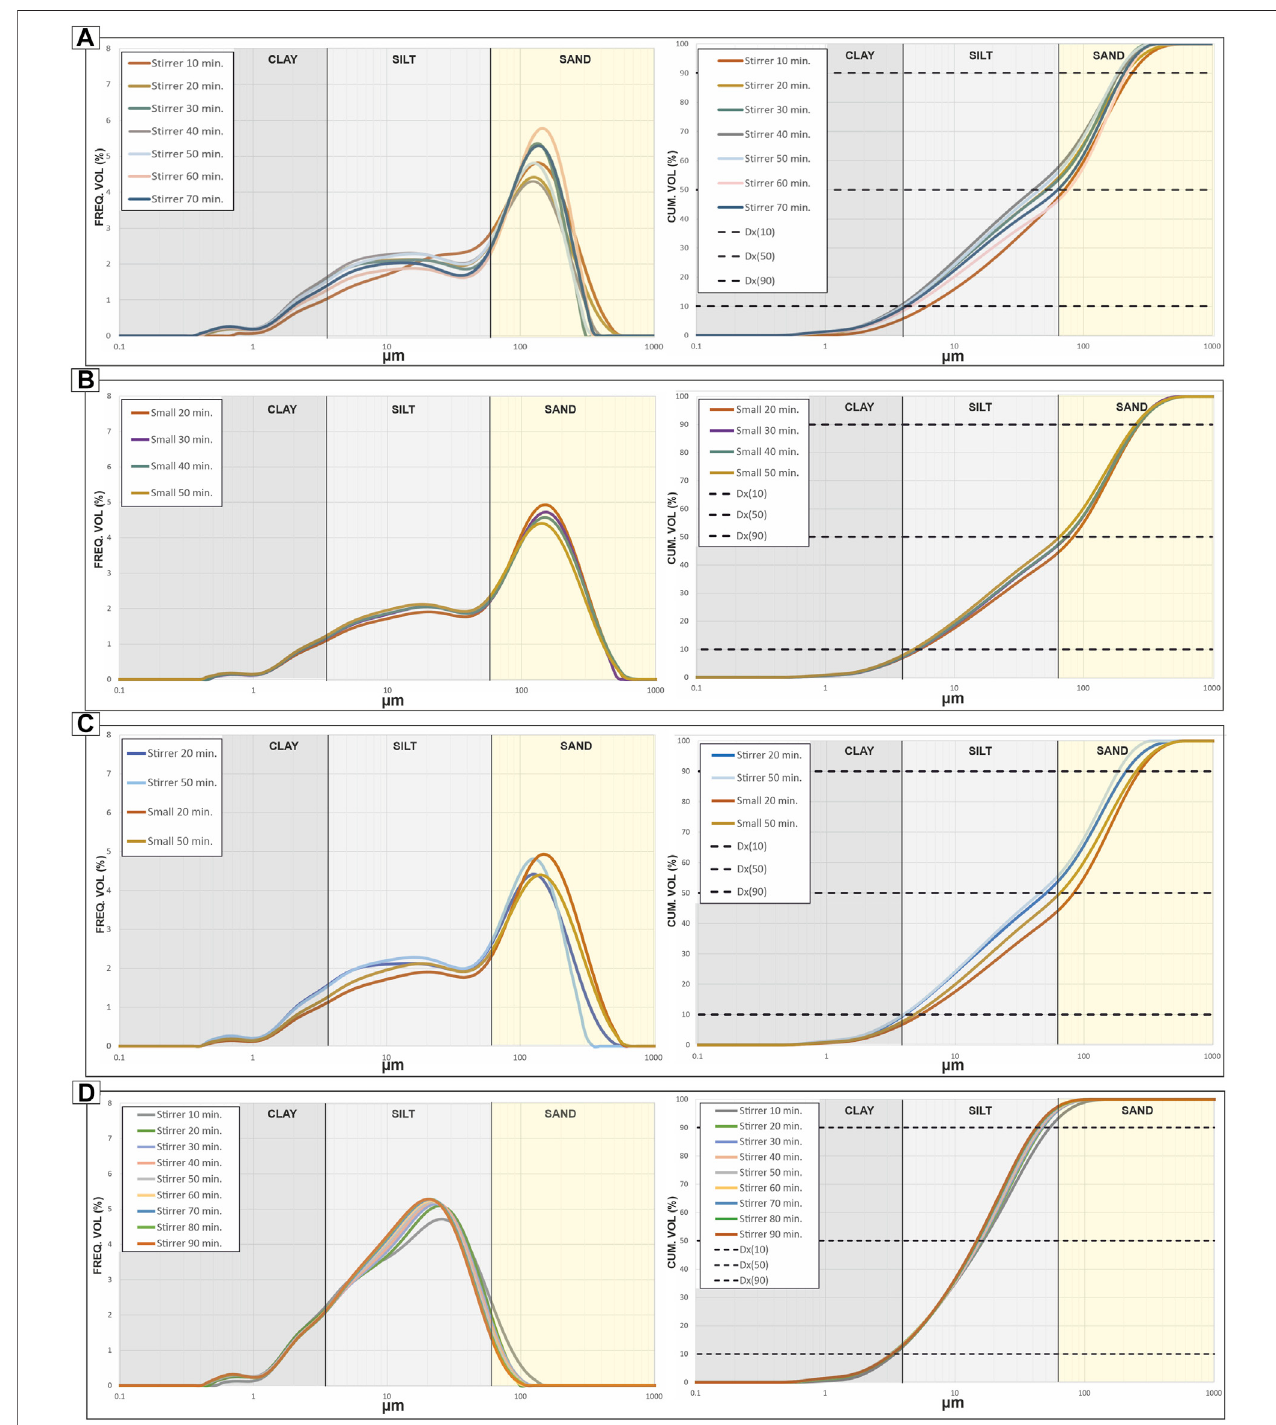
FIGURE 5 | Volume frequency and cumulative frequency graphs showing timing tests for sub-samples and aliquots processed using the ultrasonic bath method. Supplementary Table S1 for full data results. (A) Field sample II B 209 S9, Large Subsample A- aliquots extracted using the stirrer method every 10 min to establish how the result changes with more time disaggregating in the ultrasonic bath. (B) Field sample II B209 S9, Subsample B,C,D,E - Small subsamples, sample tested every 10 min from 20 min to establish how result changes with more time in the ultrasonic bath disaggregating. (C) Comparison of results from (A,B) to demonstrate similaritiesanddifferences. (D) FieldsampleVB209S22,LargeSubample-aliquotsextractedusingthestirrermethod,testingonesampleevery10 mintoestablishhow the result changes with more time disaggregating in the ultrasonic bath.